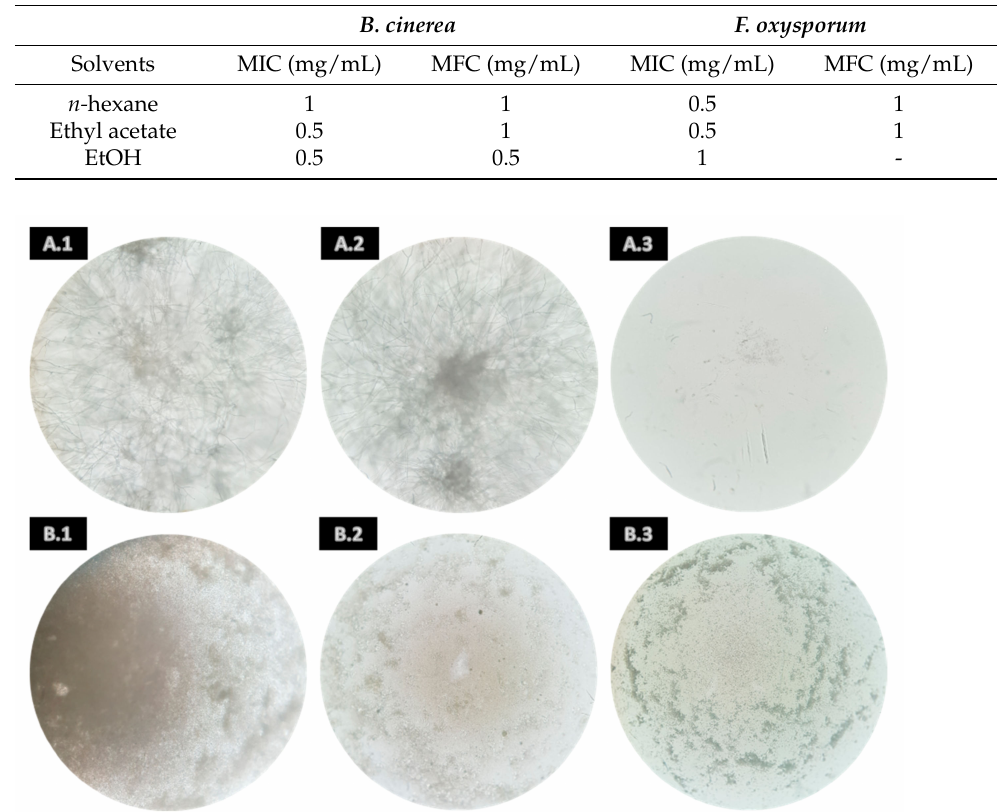
Figure 1. Representative examples of the spore germination minimum inhibitory concentration (MIC) of Botrytis cinerea by the n -hexane, ethyl acetate, and ethanolic extracts of Asparagopsis armata . Where ( A.1 ): DMSO control (0.5 mg/mL); ( A.2 ): DMSO control (1 mg/mL); ( A.3 ): amphotericin B control (2 µ g/mL); ( B.1 ): n -hexane (1 mg/mL); ( B.2 ): ethyl acetate (0.5 mg/mL); and ( B.3 ): ethanol (0.5